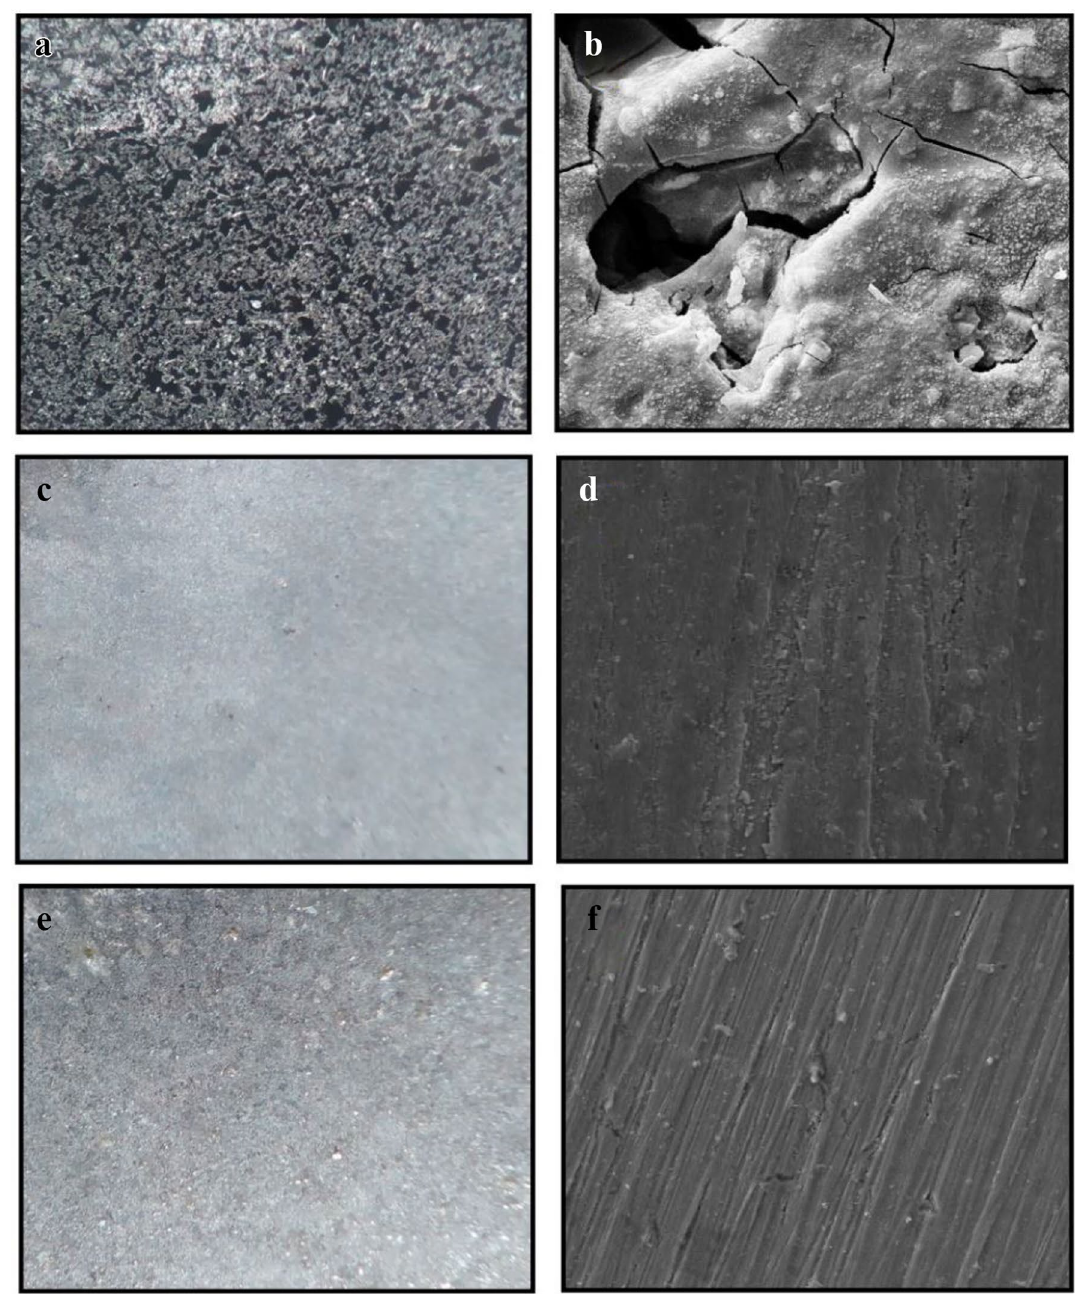
Figure 11. The images of the st-37 surface after 24 h immersion in 0.5 M H 2 SO 4 solution in the ( a , b ) absence, ( c , d ) presence of 200 ppm of Dracocephalum extract in bulk size ( e , f ), and presence of 75 ppm of Dracocephalum extract in nano size, using optical, and Scanning electron microscopy,